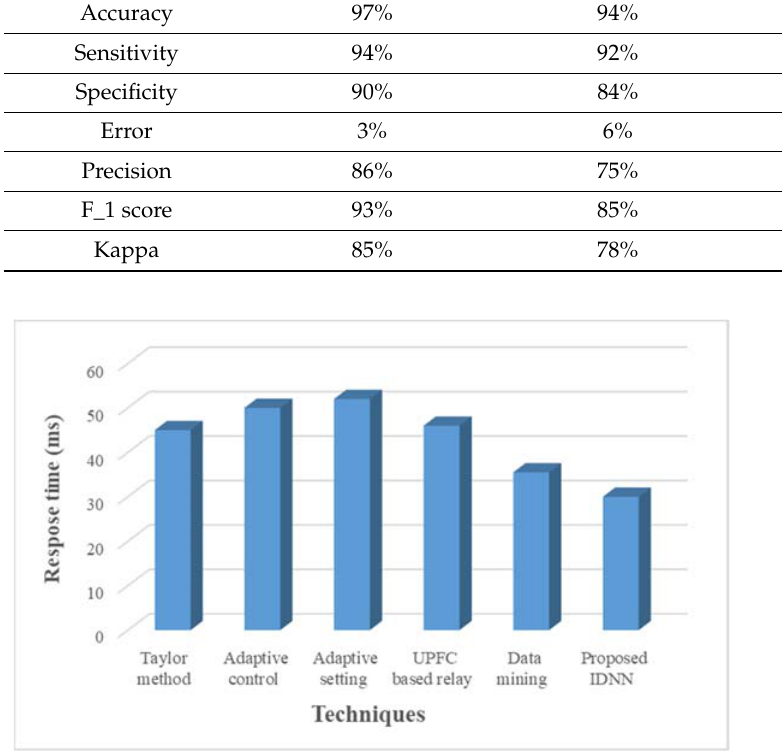
Table 4. Distance relay performance. Figure 12. The training process of ( a ) June, ( b ) July, ( c ) August.